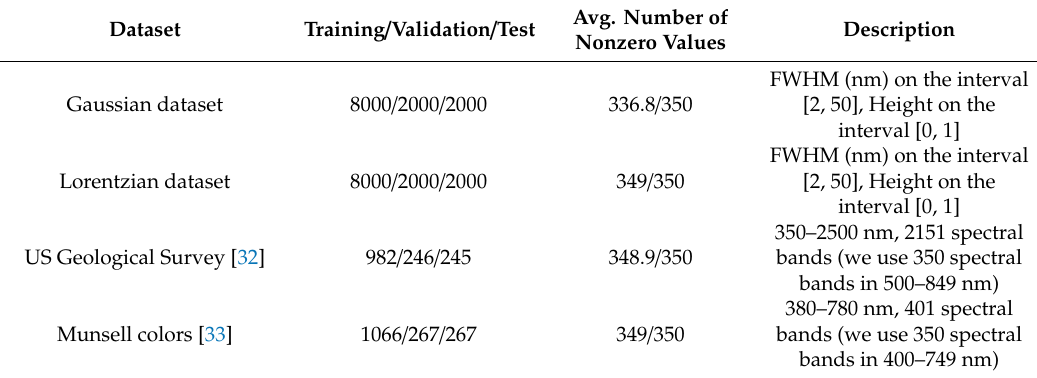
Table 1. Description of the spectral